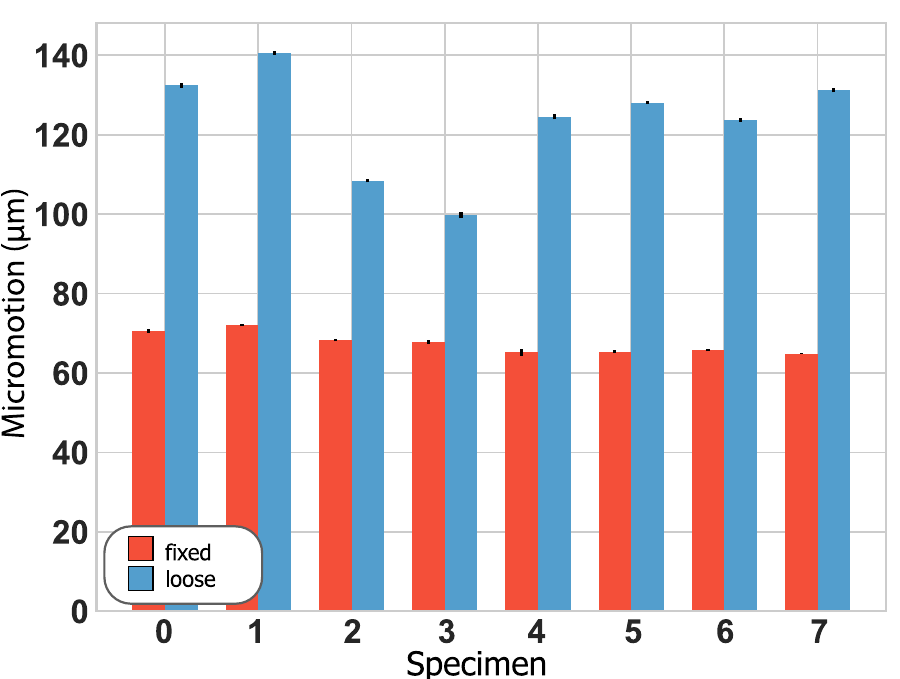
Fig 4. Average micromotion for each specimen. Error bars depict the standard deviation over all load